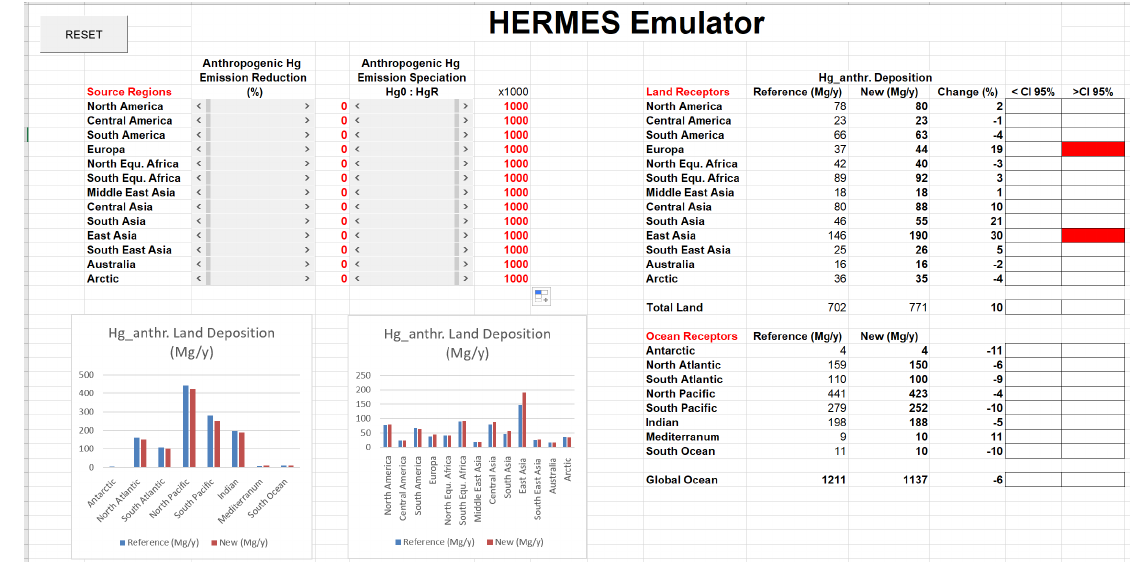
Figure 8. Use-case 6: Hg